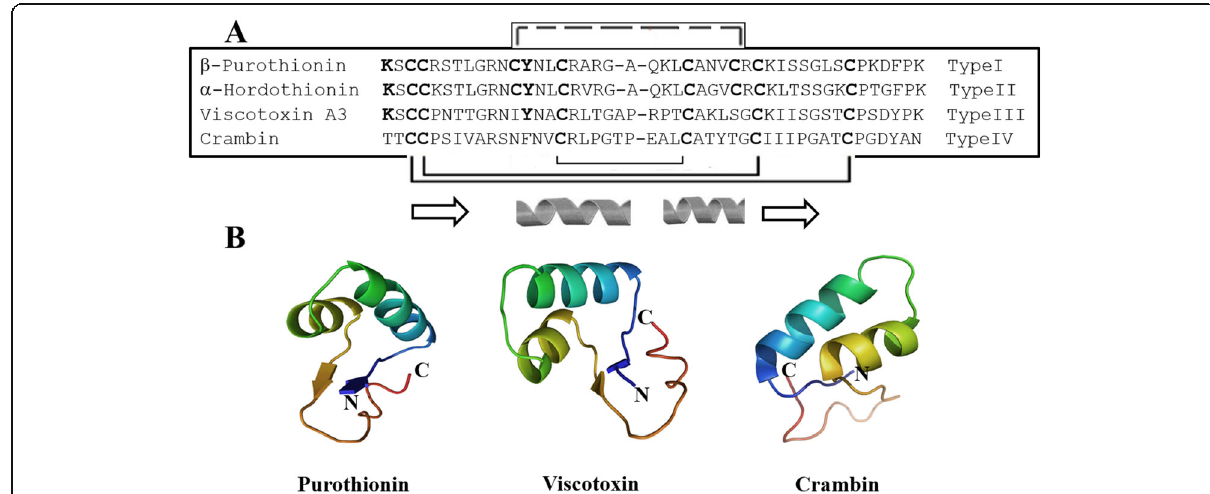
Fig. 4 Overlapping and tertiary structure of the different types of thionins. a Bold letter C in the sequence represents cysteine which involves in the formation of disulfide bridge, bold Lys (K1) and Tyr (Y13) represent conserved position which crucially involves in toxicity against fungal and animal cells, dashed bridge connection denote an extra disulfide bridge of 8C group (type I and type II) and --dash line placed in between sequence to denotes variability in length in the process of alignment of sequence and arrow and helical structure represents the presence of α -helix and β -sheet of different segments of sequence. b The tertiary structure of each represented type